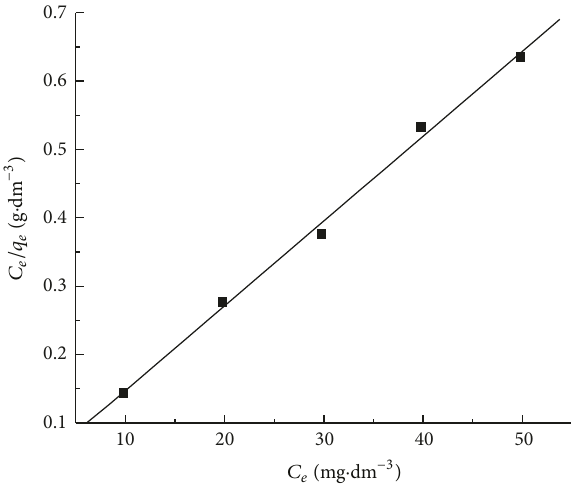
Figure 6: Effect of dosage of adsorbent for Cr(VI) adsorption using hybrid membrane of carboxymethyl chitosan and silicon dioxide.